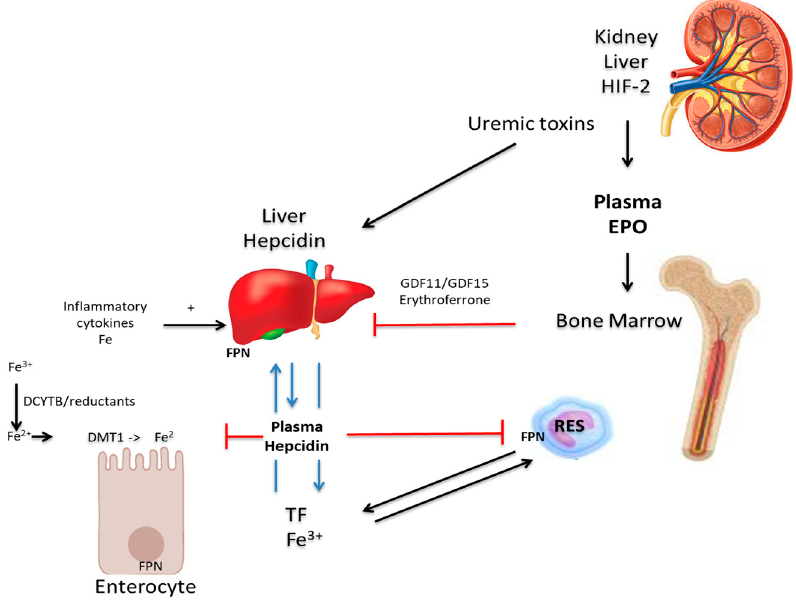
Figure 1. Iron metabolism and the mechanisms of renal anemia. In the enterocyte, duodenal cytochrome b (DCYTB) and other dietary reducing agents reduce ferric iron (Fe 3+ ) to its ferrous (Fe 2+ ) state, via the divalent metal transporter 1 (DMT1). Iron efflux into the circulation occurs via hepcidin- regulated ferroportin (FPN). In blood, iron is transported bound to transferrin (TF) to the liver, cells of the reticulo-endothelial system (RES) and to other tissues and organs. Inflammatory cytokines suppress erythropoiesis in the bone marrow and stimulate hepcidin production in the liver, which influences iron absorption and efflux negatively. Decreased GDF11/GDF15 or erythroferrone leads to